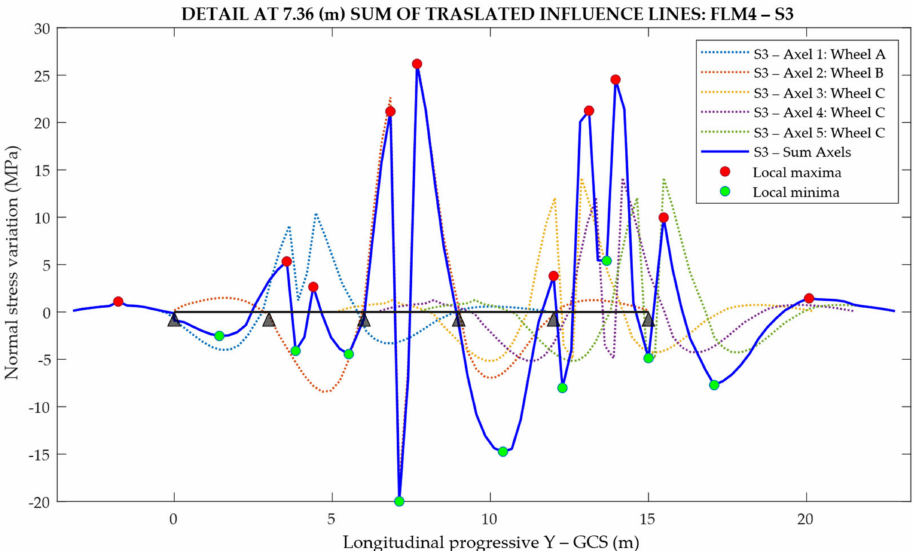
Figure 26. Stress spectrum for the transit of the lorry silhouette 3 from the FLM4.